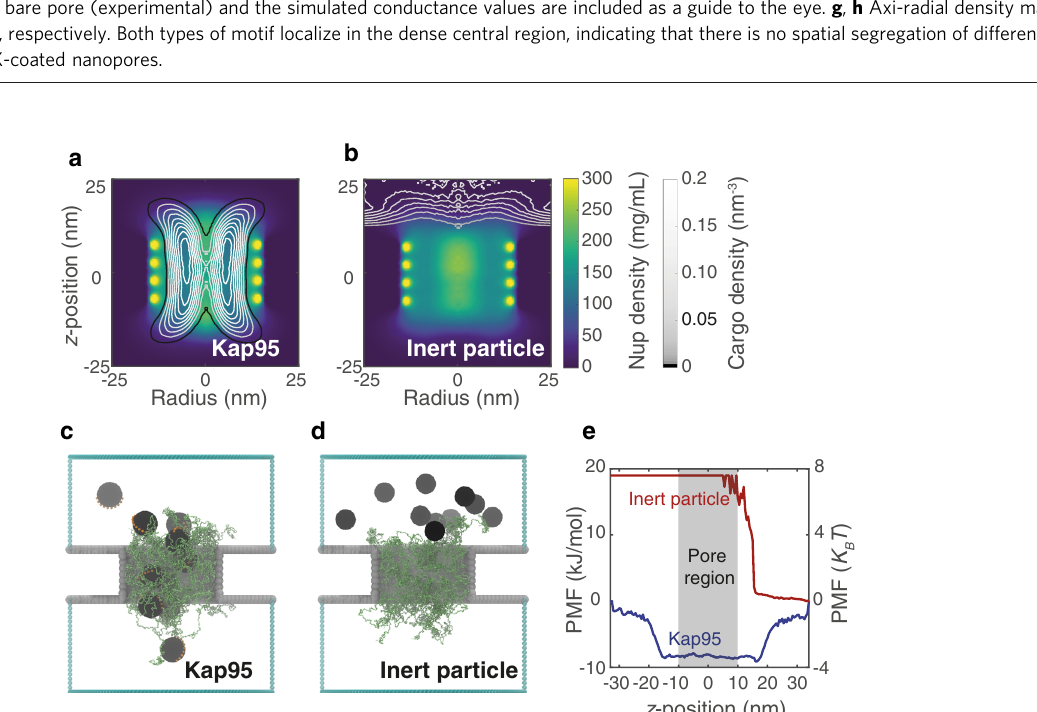
Fig. 5 Effect of transporters on NupX-lined biomimetic pores. a Contour graphs of the Kap95 number density (grey contours) superimposed on the NupX protein density distributions (in the presence of Kap95) within a 30 nm NupX-lined nanopore (NupX-density follows the same colouring scheme as in Fig. 4b and is shown separately in Supplementary Fig. 19). The protein meshwork adapts (as compared to the distribution in Fig. 4b) to accommodate the permeating Kap95 particles. b Density distribution of inert particles superimposed on the NupX protein density distribution in a 30 nm diameter NupX- lined nanopore. Inert particles remain in the top compartment and do not permeate the NupX protein meshwork. c, d Simulation snapshots of 30 nm NupX- lined nanopores in the presence of Kap95 particles ( c , black spheres with orange binding spots) and inert particles ( d , black spheres), which were released in the top compartment. Kap95 particles enter and exit the NupX meshworks at either side of the nanopore, whereas inert particles remain in the top compartment. e PMF curves of Kap95 (blue) and inert particles (red) along the z -coordinate, obtained via Boltzmann inversion of the normalized density pro fi le along the z -axis. The pore region coincides with an energy well of over 3 k B T for Kap95, whereas inert particles experience a steep energy barrier of ~7 k B T